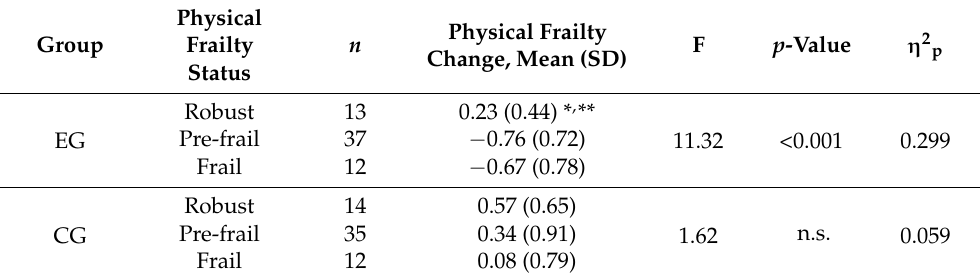
Table 5. Comparison of physical exercise effects on different levels of physical frailty in EG and CG based on one-way ANCOVA. Physical n Group Frailty Status